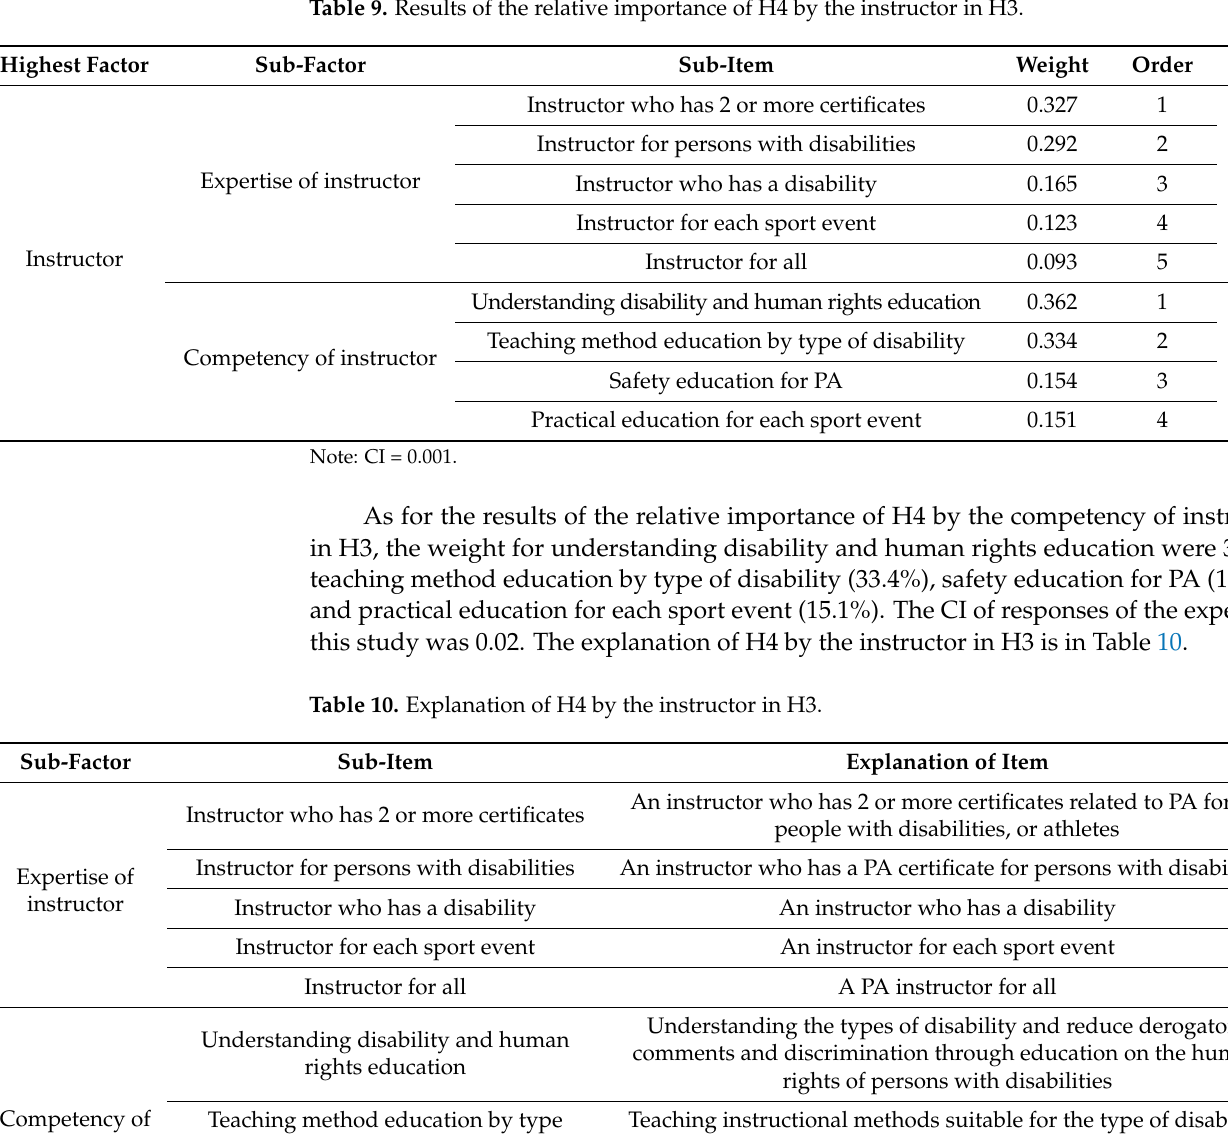
Table 9. Results of the relative importance of H4 by the instructor in H3.